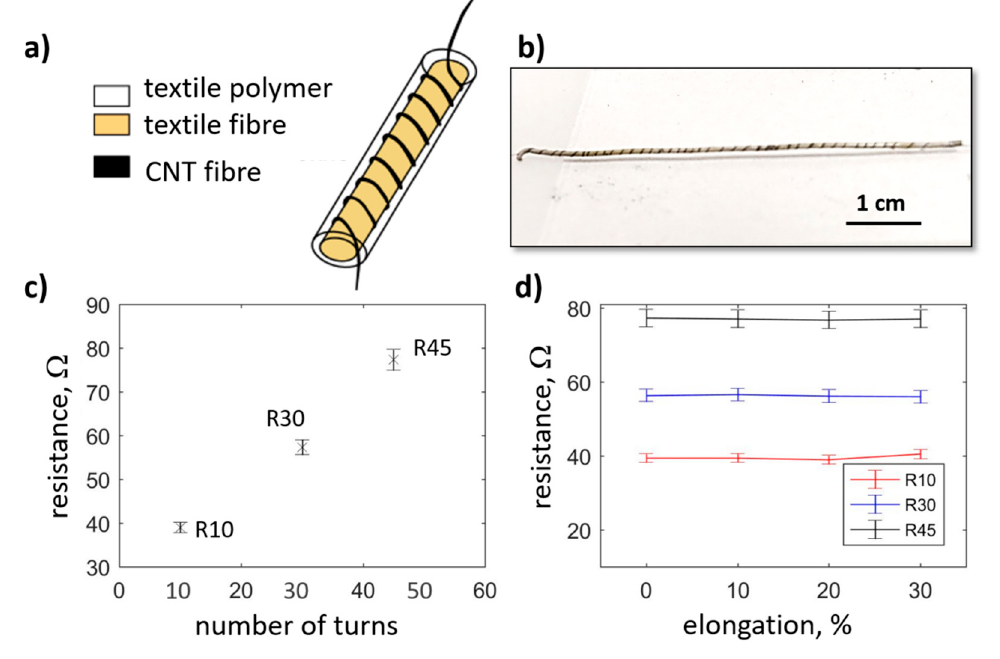
Figure 2. ( a ) Design of a textile resistor, and ( b ) an image of a manufactured element. ( c ) Change of resistance of the resistors with an increasing number of turns. ( d ) Stability of resistance upon strain applied to the resistors.